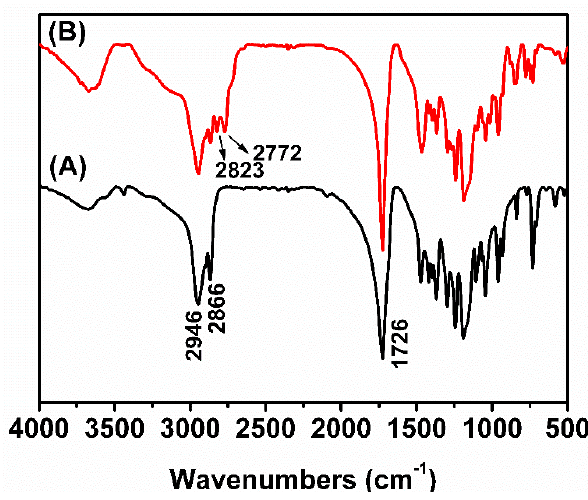
Figure 4. FT–IR spectra of PCL-SS-iBuBr ( A ) and PCL-SS-PDMAEMA ( B ).